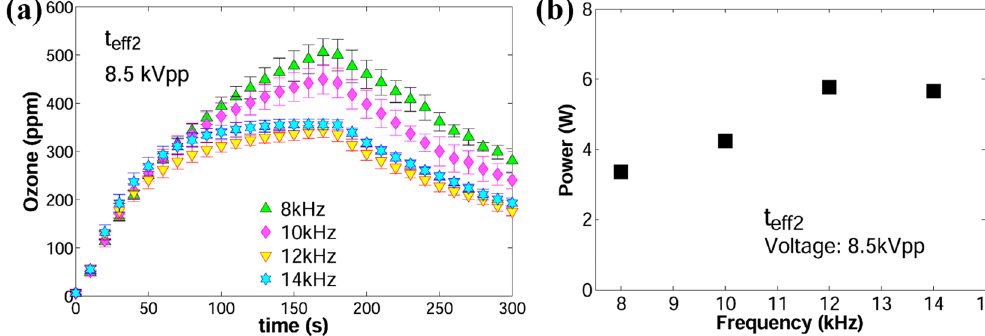
Figure 11. Curves of ozone vs. time in the frequency range 8–14 kHz. ( a ) Ozone rate vs. time. ( b ) Power vs frequency. Applied voltage = 8.5 kVpp; t eff = 0.05 mm ( t eff 2